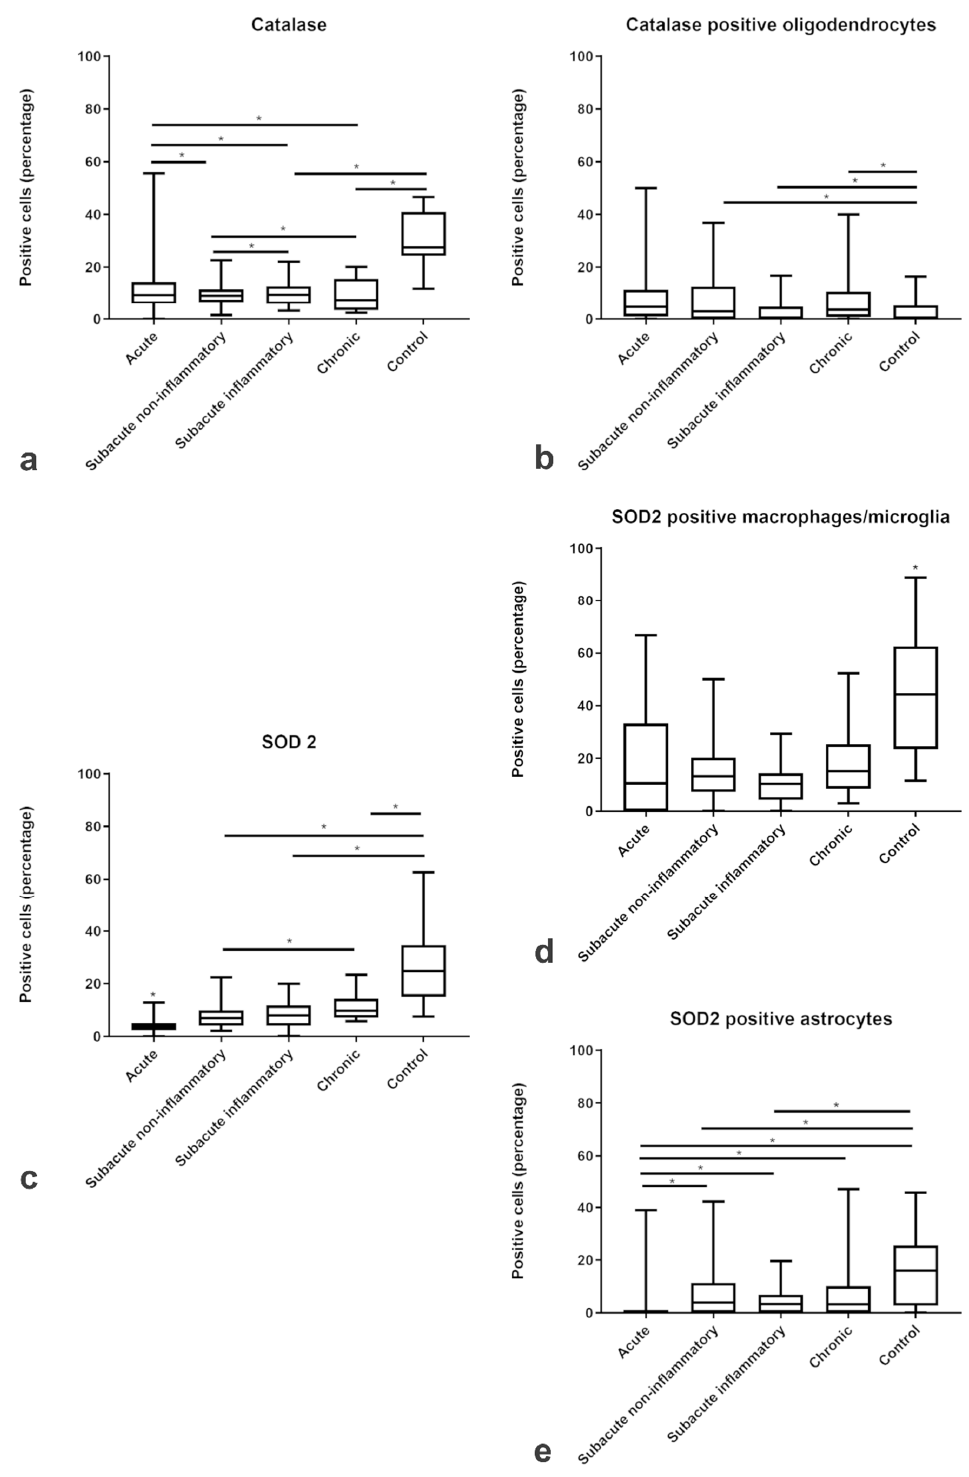
Figure 5. Relative changes in the proportions of cells immunopositive for antioxidative enzymes in CDV-DL. The box plots show the decreasing percentage of positive cells for antioxidant enzymes ( a ) and SOD2 ( c )) and the percentage of positive ( b ) oligodendrocytes, ( d ) macrophages / microglia, and ( e ) astrocytes positive for antioxidant enzymes in acute, subacute non-inflammatory, subacute inflammatory, and chronic lesion compared to controls. Significant di ff erences between the groups as revealed by the Kruskal–Wallis test with independent pairwise post-hoc Mann–Whitney U-test are marked with an asterisk (* p ≤